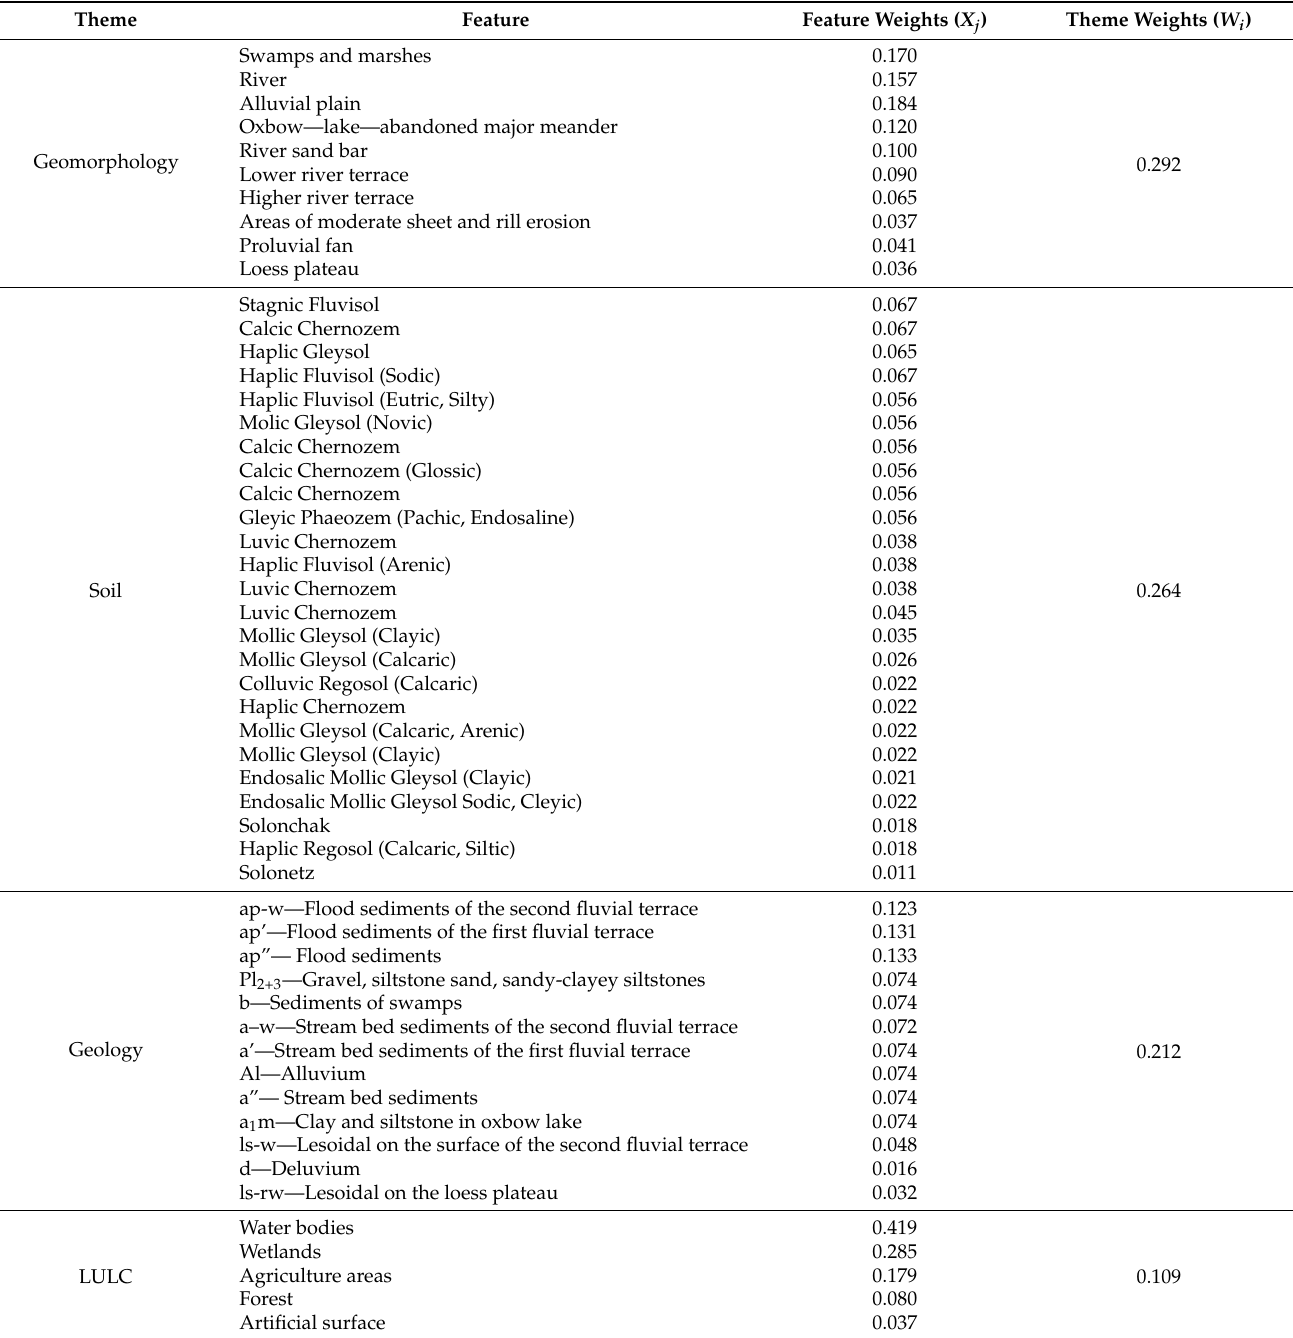
Table 5. Fuzzy AHP weights for six themes and their features for groundwater potential zones